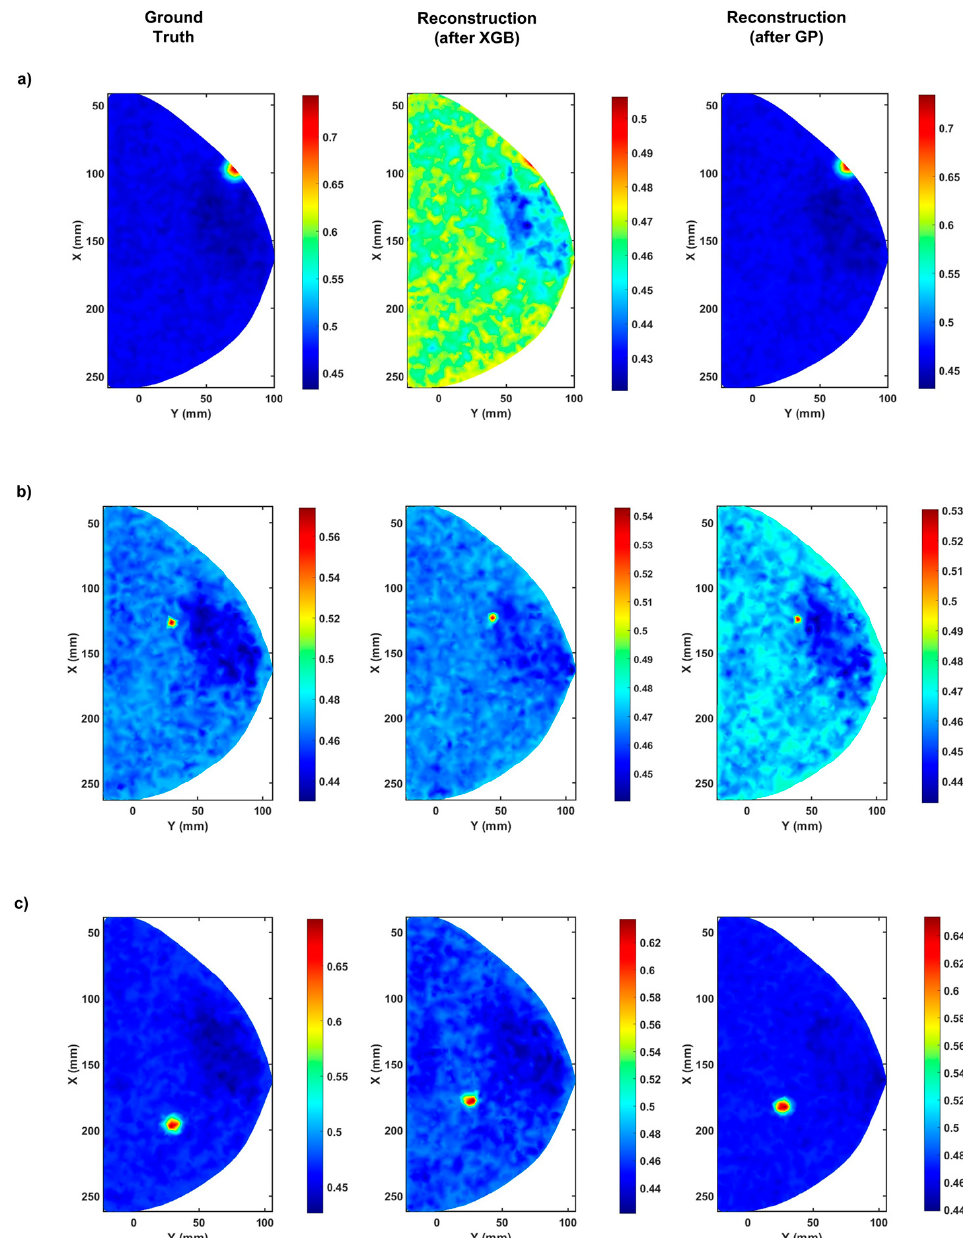
Figure 4. The reconstructed tumor locations using predictions from the GP post-processing algorithm. ( a ) showing the reconstructed tumor locations at ( z = 14.375 mm), ( b ) showing the reconstructed tumor locations at ( z = 5.325 mm), and ( c ) showing the reconstructed tumor locations at ( z = 11.289), are different examples of the XGBoost and GP predictions. The color bar shows the absorption coefficient in (cm − 1 ).